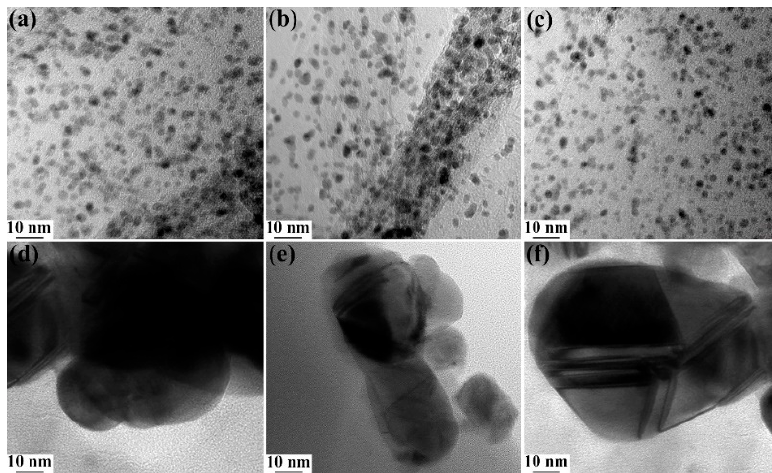
Figure 6. HRTEM images of ( a ) GO-Ag NPs, ( b ) GO-Cu NPs, ( c ) GO-Pt NPs, ( d ) GO/Ag/DBSA–PANI, ( e ) GO/Cu/DBSA–PANI, and ( f ) GO/Pt/DBSA–PANI.